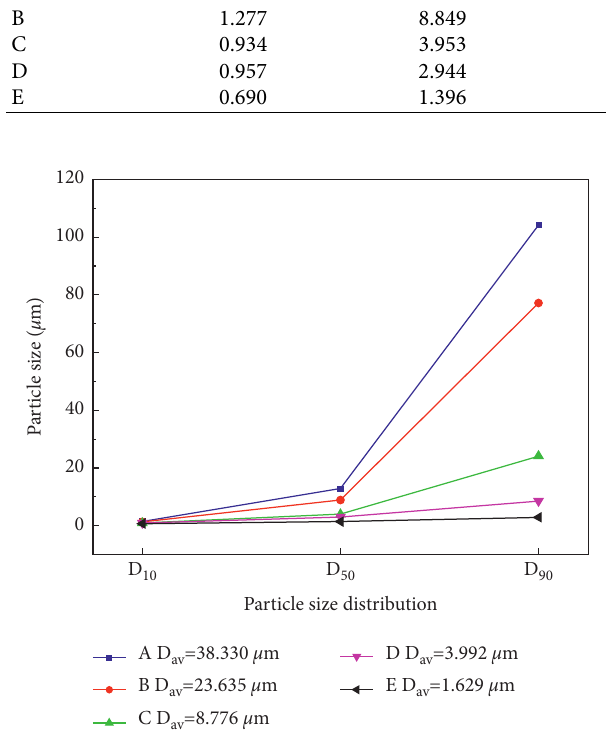
Figure 4: Particle size distribution of PPA with different fineness.